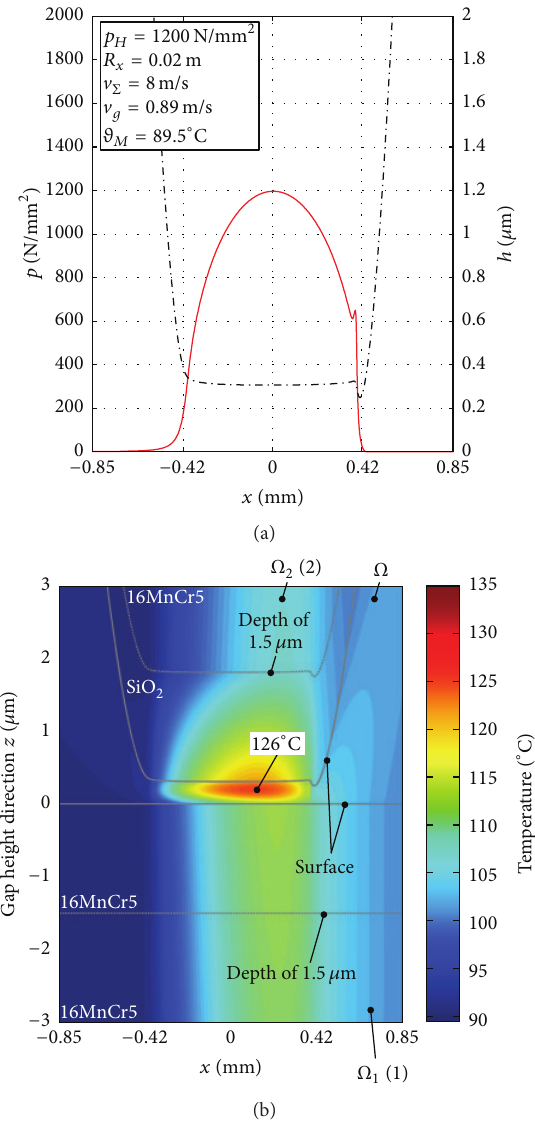
Figure 6: Pressure and film thickness (a) and temperature distribu- tion (b) of a TEHL contact with coated (SiO 2 ) upper solid acc. to Lohner et al. [27].